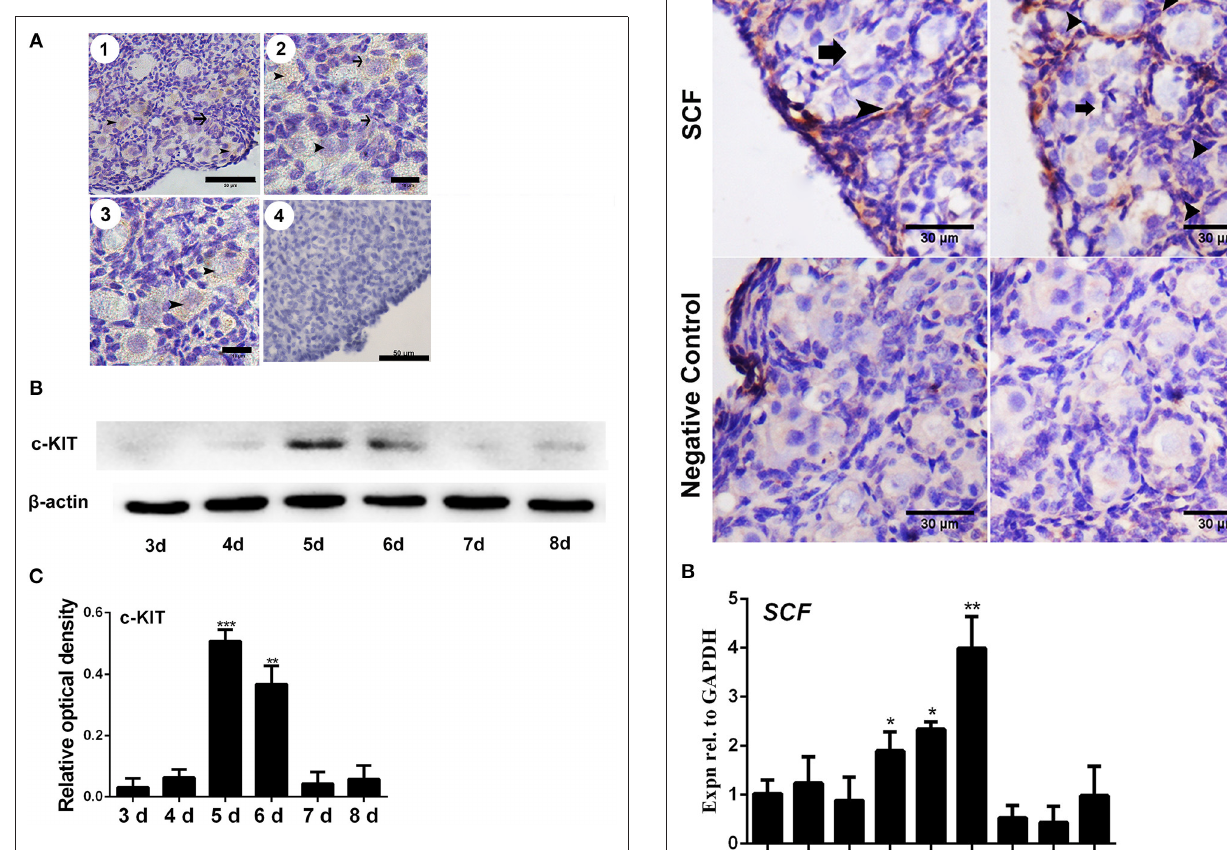
Frontiers in Endocrinology |